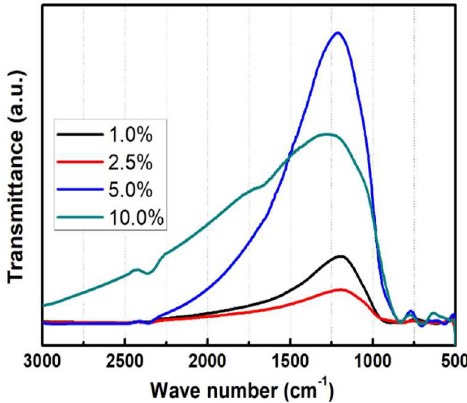
Figure 5. Evolution with dopant concentration of the infrared spectra of Mn-doped Nb 2 O 5 submitted at 700 ◦ C.